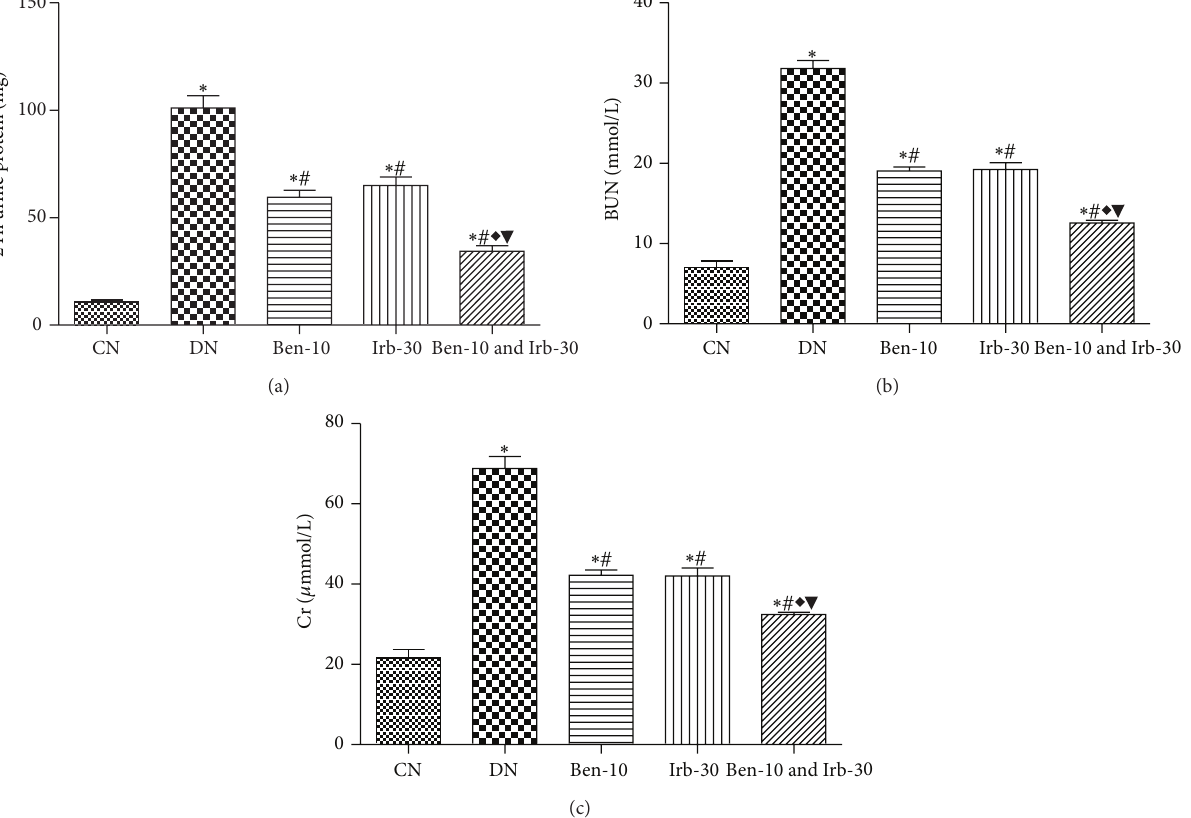
Figure 1: The effect of benazepril and irbesartan on the levels of 24 h urine protein (a), BUN (b), and Cr (c); CN: normal control group, group 1; DN: diabetic nephropathy control group, group 2; Ben-10, group 3 (benazepril 10mg/kg/d); Irb-30, group 4 (irbesartan 30 mg/kg/d); and Ben-10 and Irb-30, group 5; and compared with group 1, ∗ 𝑃 < 0.05 ; compared with group 2, # 𝑃 < 0.05 ; compared with group 3, X 𝑃 < 0.05 ; compared with group 4, 󳶃 𝑃 < 0.05 ; BUN: blood urea nitrogen; Cr: serum